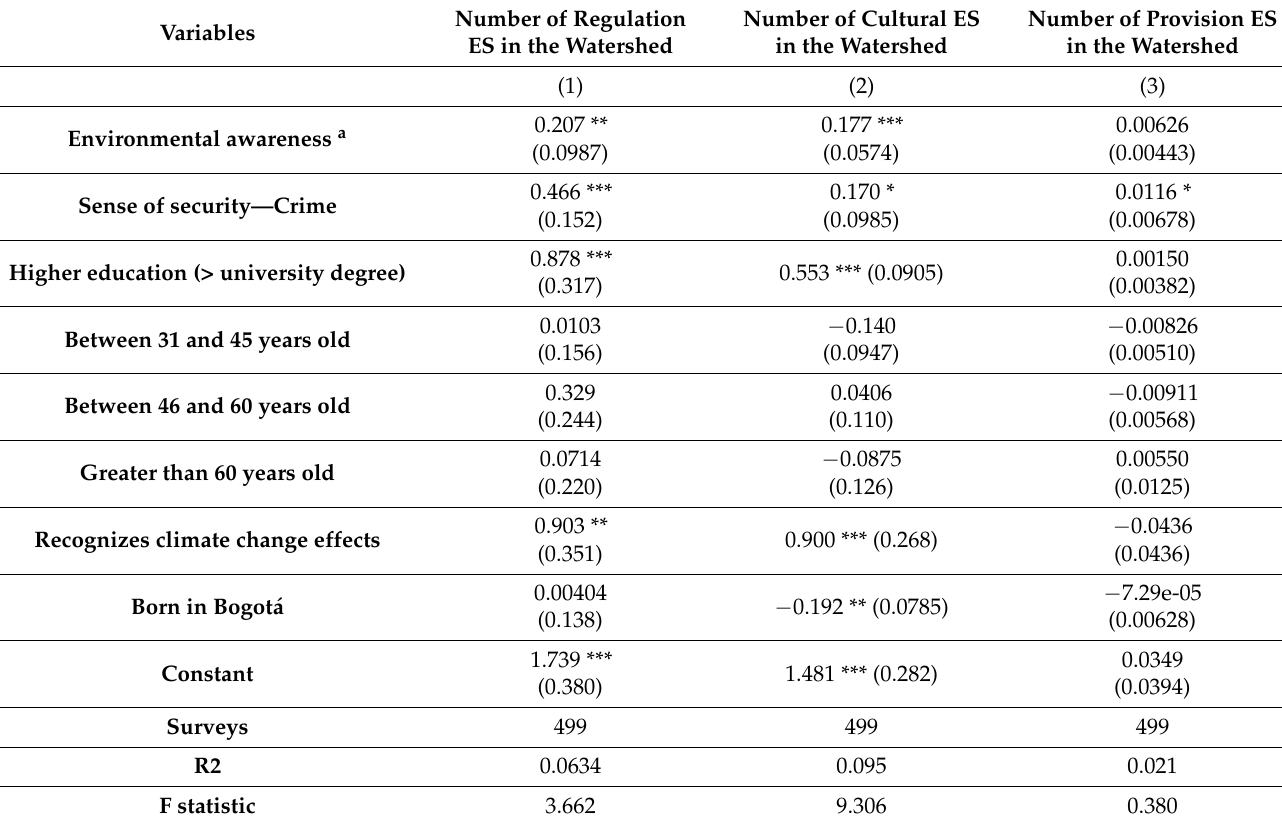
Table 5. Ordinary least squares regression model for socioeconomic factors that influence the environmental, cultural, and provision benefits identified in the El Salitre watershed (Robust standard errors in parenthesis) *** p < 0.01, ** p < 0.05, * p < 0.1.